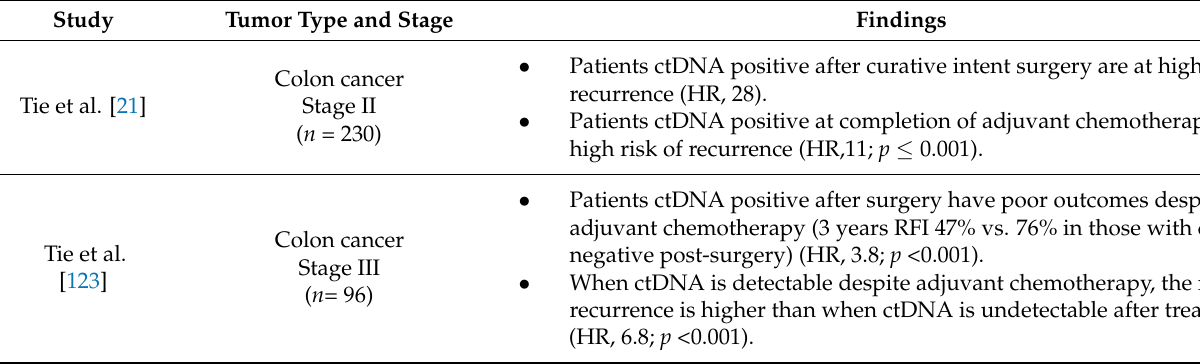
Table 1. ctDNA as a biomarker of MRD, therapeutic efficacy, and surveillance in CRC patients. Studies of plasma ctDNA in CRC and their main findings are shown. The number of patients included in each study is indicated ( n ). PFS, progression-free survival; OS, overall survival; CT, computed